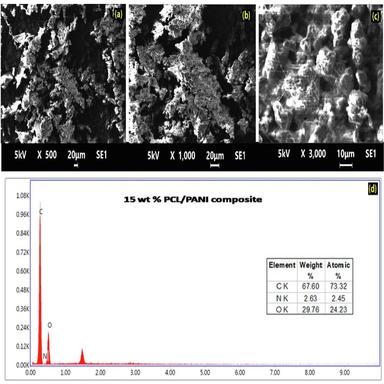
SEM and EDX images of 15 wt% (a, b, c, d) PCL and PANI composites.